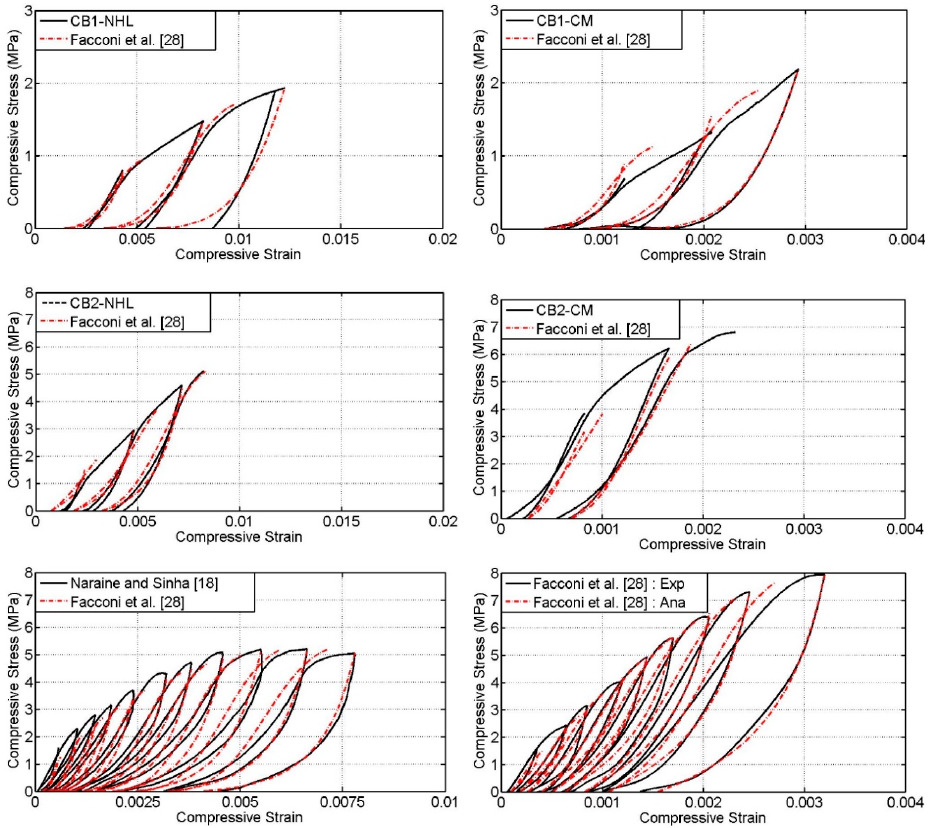
Figure 7. Comparisons of experimental and analytical unloading and reloading curves.